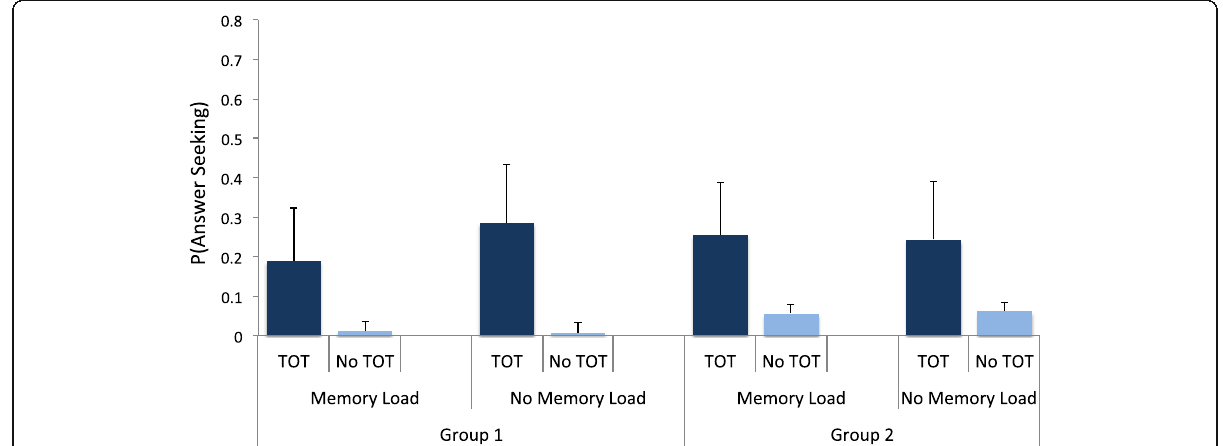
Fig. 3 Probability of answer seeking given that the response was correct. Error bars : standard error of the mean. TOT :